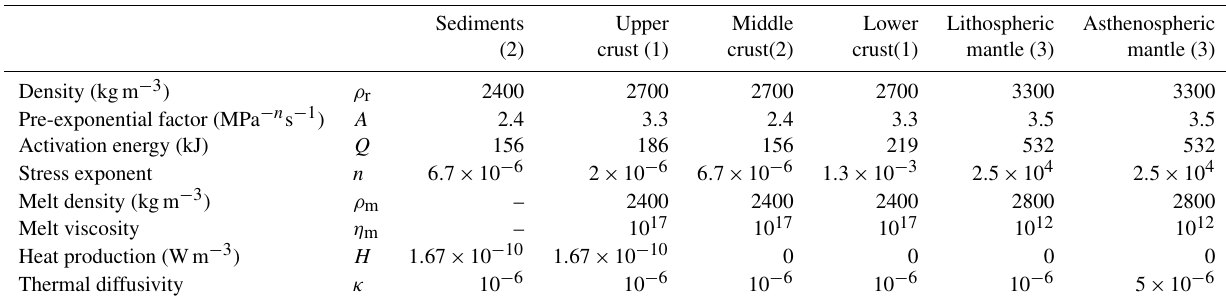
Table A1. Values and notation for variable physical parameters. Parameters for dislocation creep come from 1 (Ranalli and Murphy, 1987), 2 (Hansen and Carter, 1982) and 3 (Chopra and Paterson, 1984). Other constant parameters include friction ϕ and cohesion C, which varies linearly with plastic strain in the range [0,1] from 30 to 20 ◦ and from 20 to 2MPa; the coefficients of thermal expansion and compressibility are set to 3 × 10 − 5 K − 1 and 10 − 11 Pa − 1